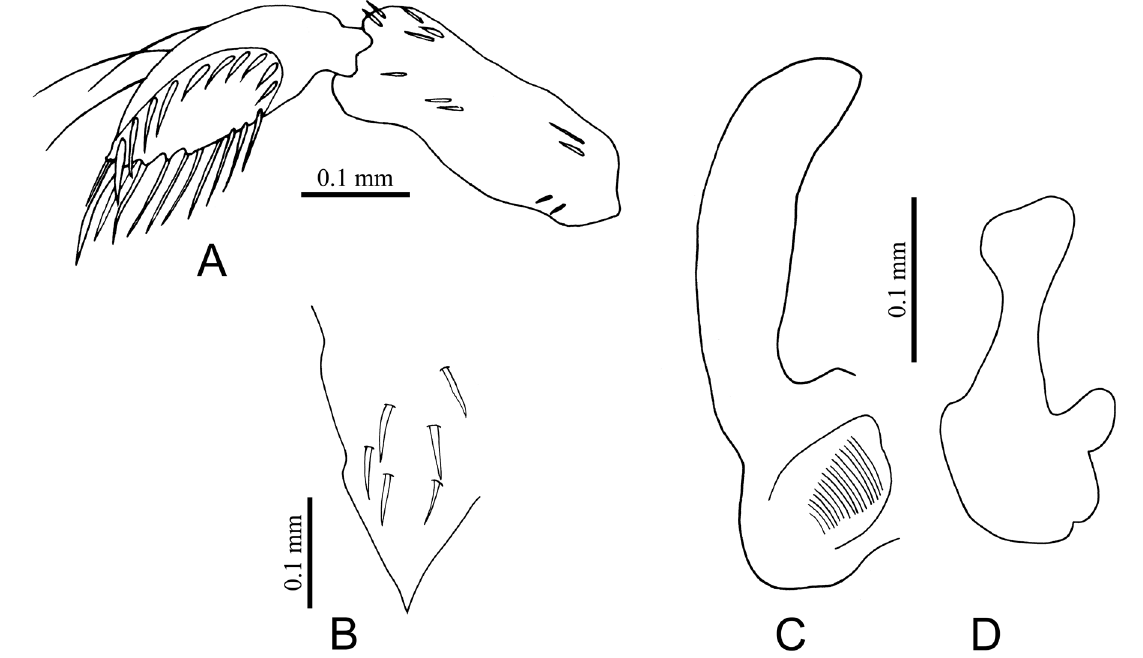
Fig. 26. Morphological features of Synaptonecta issa (Distant, 1910), ♂ (ZVNU). A . Fore leg. B . Median lobe of sternite VII. C . Right paramere. D . Left